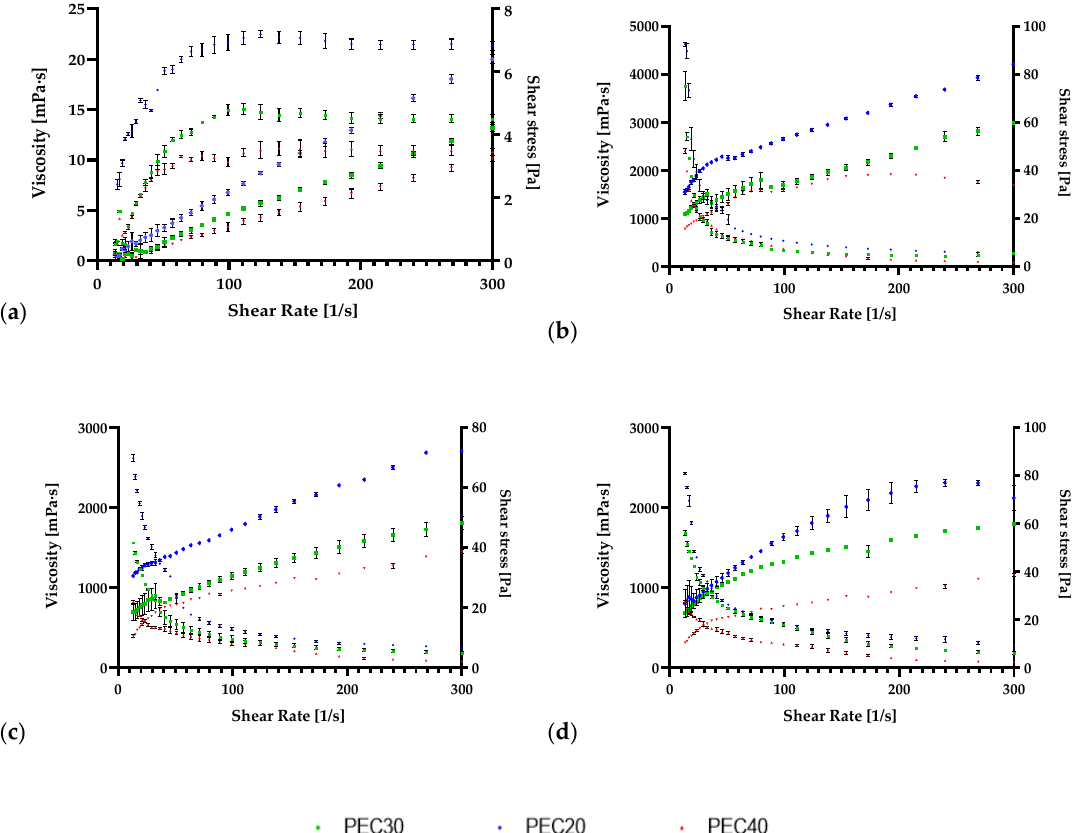
Figure 1. Shear viscosity and shear rate of pectin and itaconic acid-based biofilms at 20, 30, and 40 °C temperature. The reported mean values with standard deviation (±) are displayed for ( a ) pectin + glycerol; ( b ) pectin + glycerol+ itaconic acid; ( c ) pectin + glycerol + itaconic acid + phenolic extract; ( d ) pectin + glycerol + itaconic acid + organic extract.